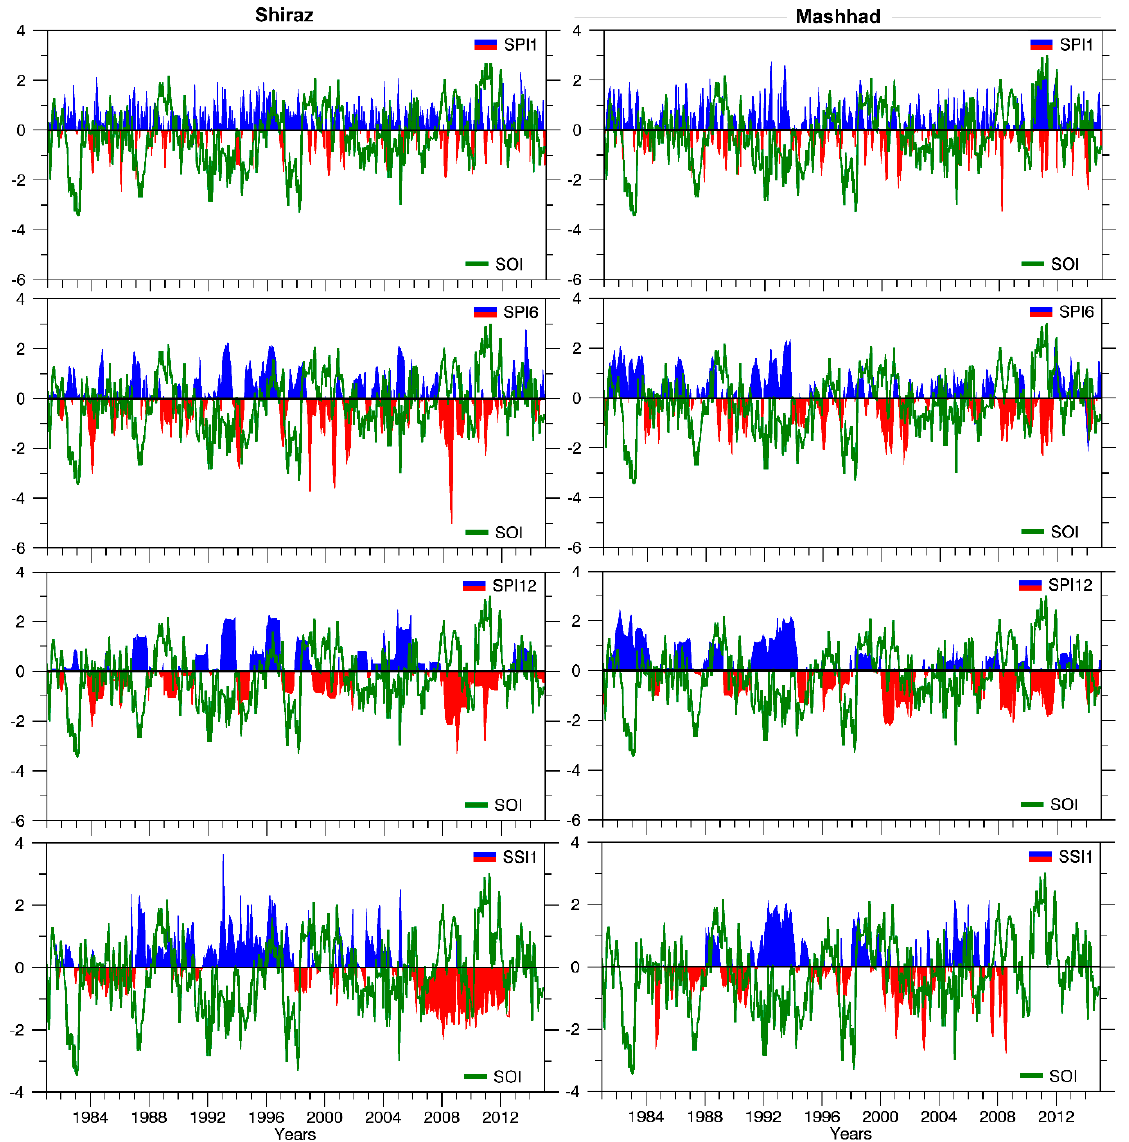
Figure 7. Temporal variations of 1-month, 6-month, and 12-month SPI and SSI with the variations of SOI in the Shiraz and Mashhad boxes. Negative SPI and SSI values—drought conditions in red, positive SPI and SSI values—wet conditions in blue and SOI variations in green color.